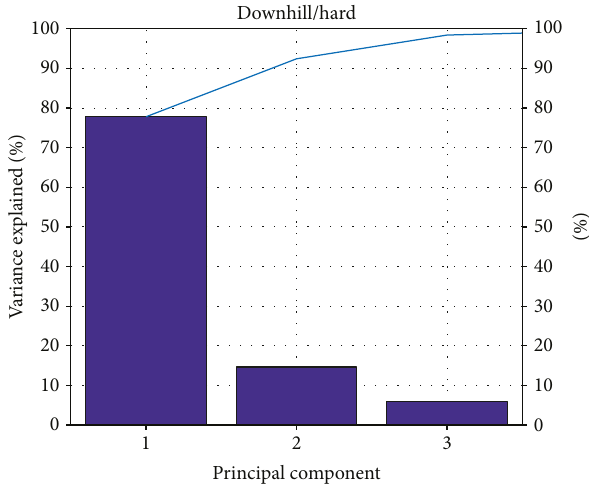
Figure 8: The relationship between the principal component and the variance explained for